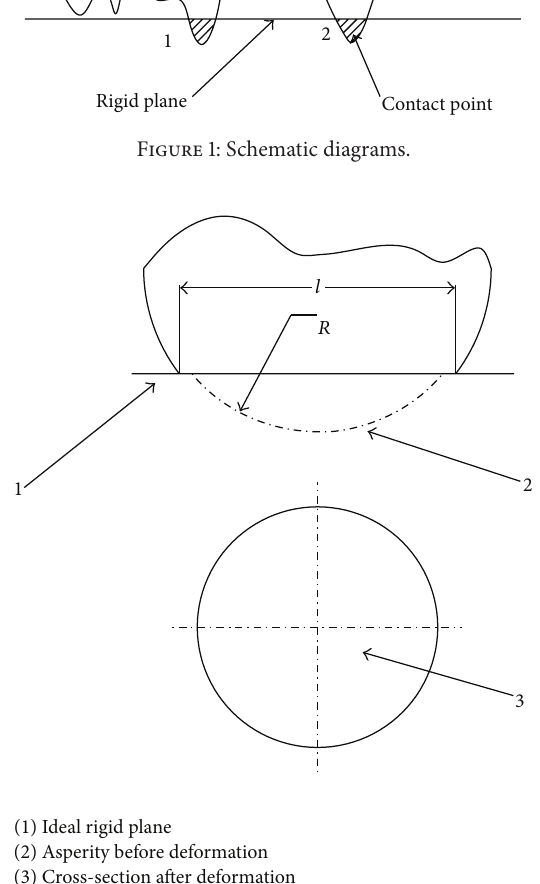
Figure 2: Schematic diagram of the contact of a single